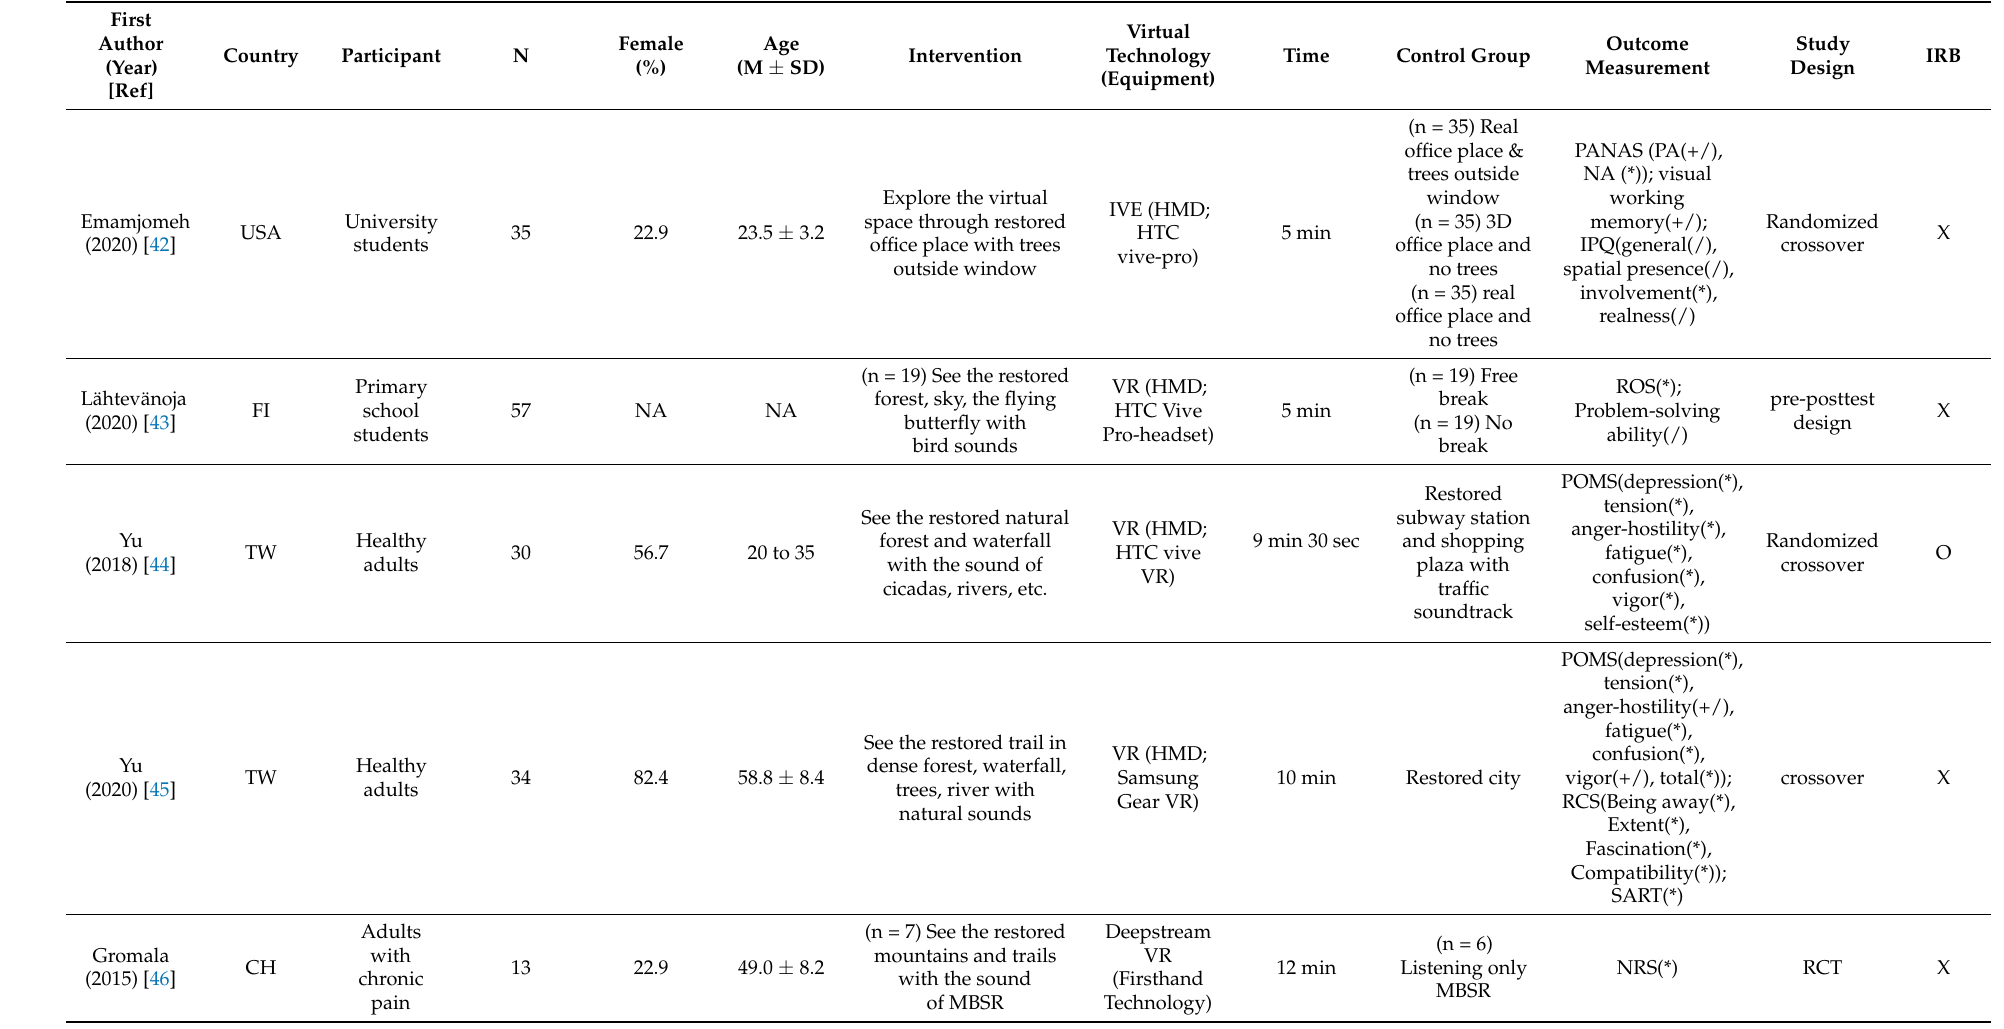
Table 3. Main characteristics of the included